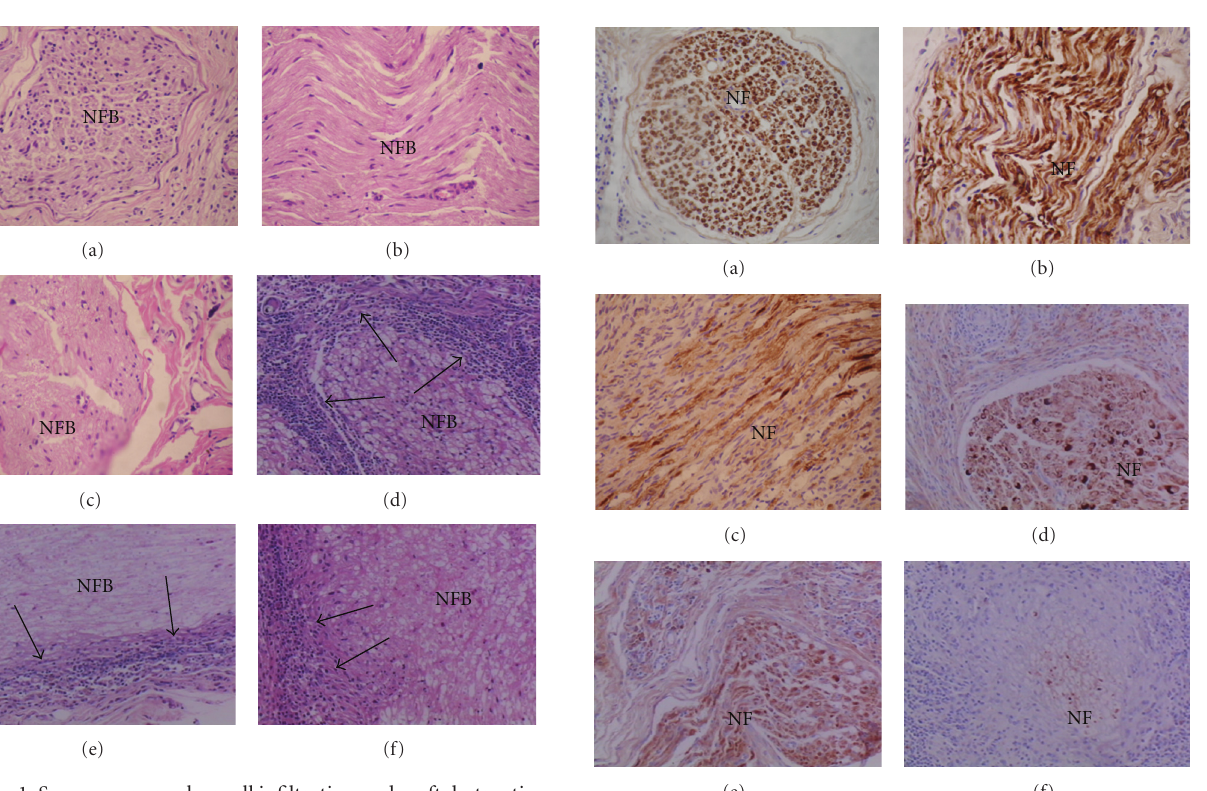
Figure 1: Severe mononuclear cell infiltration and graft destruction in mouse nerve xenografts. Autologous (a)–(c) and xenogeneic mouse (d)–(f) nerve grafts were harvested at weeks 2 (a) and (d), 4 (b) and (e), and 8 (c) and (f) posttransplantation and analyzed by light microscopy with H&E staining. Five rats per group were examined at each time point, and representative samples ( x 40) are shown. Mononuclear cell infiltration was detected (arrowheads) around nerve fiber bundle (NFB) in mouse nerve xenografts at all time points examined.